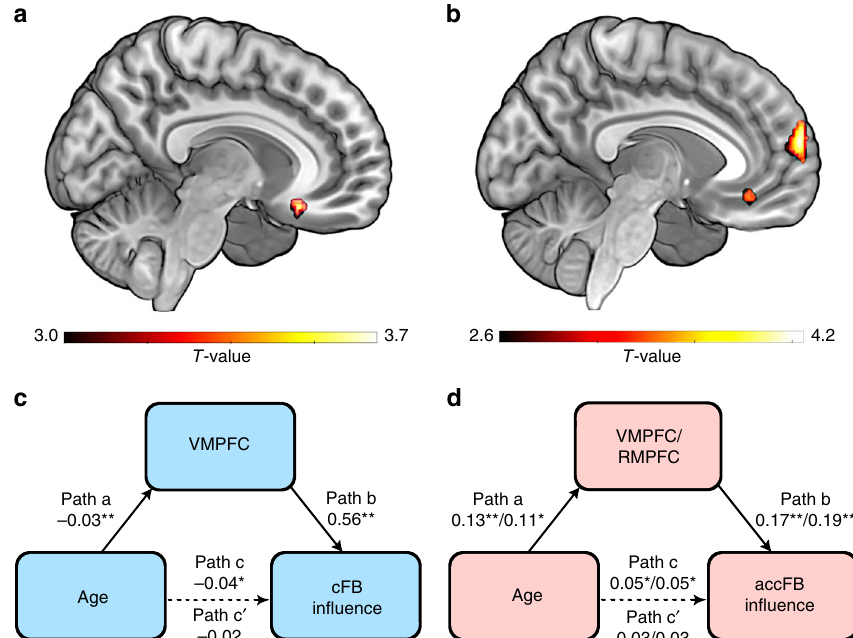
Fig. 3 Neural mediators of age-related changes in cFB and accFB in fl uence. a Statistical parametric map depicting VMPFC (SVC FWE < 0.05) signals differentiating cFB varying from negative to positive values at the feedback receipt event, which correlated positively with individual differences in the cFB in fl uence (see also Supplementary Table 2). b Statistical parametric map depicting VMPFC (SVC FWE < 0.05) and RMPFC (whole-brain and SVC FWE < 0.05) signals differentiating accFB varying from negative to positive values at the partner-evaluation event, which correlated positively with individual differences in the accFB in fl uence (see also Supplementary Table 2). c Age-related decrease in the cFB in fl uence was mediated by the cFB-related parametric modulation estimates of VMPFC ( a ) (The numbers indicate regression coef fi cients. * p < 0.05, ** p < 0.01; Bootstrapping mediation analysis). d Age-related increase in the accFB in fl uence was mediated by the accFB-related parametric modulation estimates of VMPFC and RMPFC ( b ) (Regression coef fi cients before and after the slash correspond to VMPFC and RMPFC, respectively. * p < 0.05, ** p < 0.01; Bootstrapping mediation